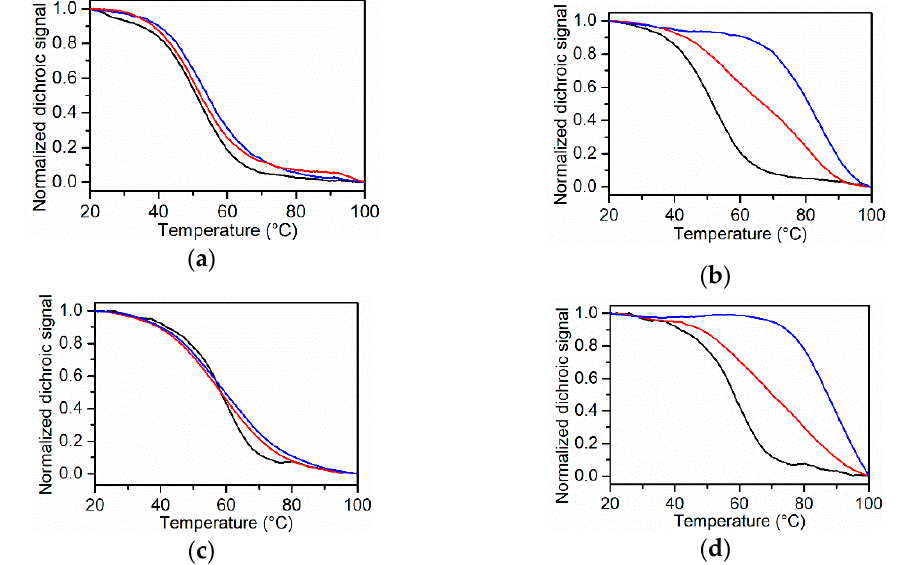
Figure 5. CD melting curves of ( a ) KRAS 22RT and ( c ) KRAS 32R in the absence (black line) and in the presence of 1 (red line) and 2 equivalents of TMPyP4 (blue line). CD melting curves of ( b ) KRAS 22RT and ( d ) KRAS 32R in the absence (black line) and in the presence of 1 (red line) and 2 equivalents (blue line) of BRACO-19. The buffer solution was 20 mM KH 2 PO 4 /K 2 HPO 4 with 60 mM KCl and 0.1 mM EDTA at pH 7.0.